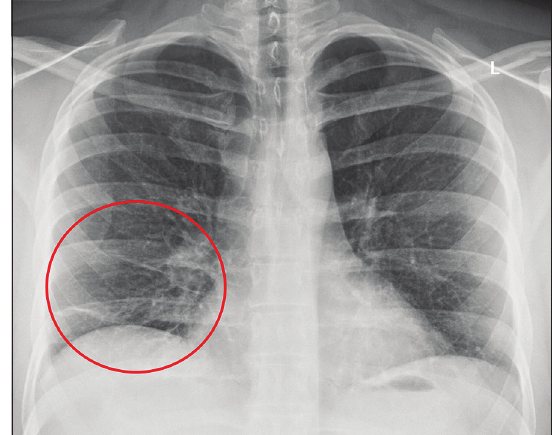
FIGURE 6. Chest X-ray – January 27, 2020 – left profile.